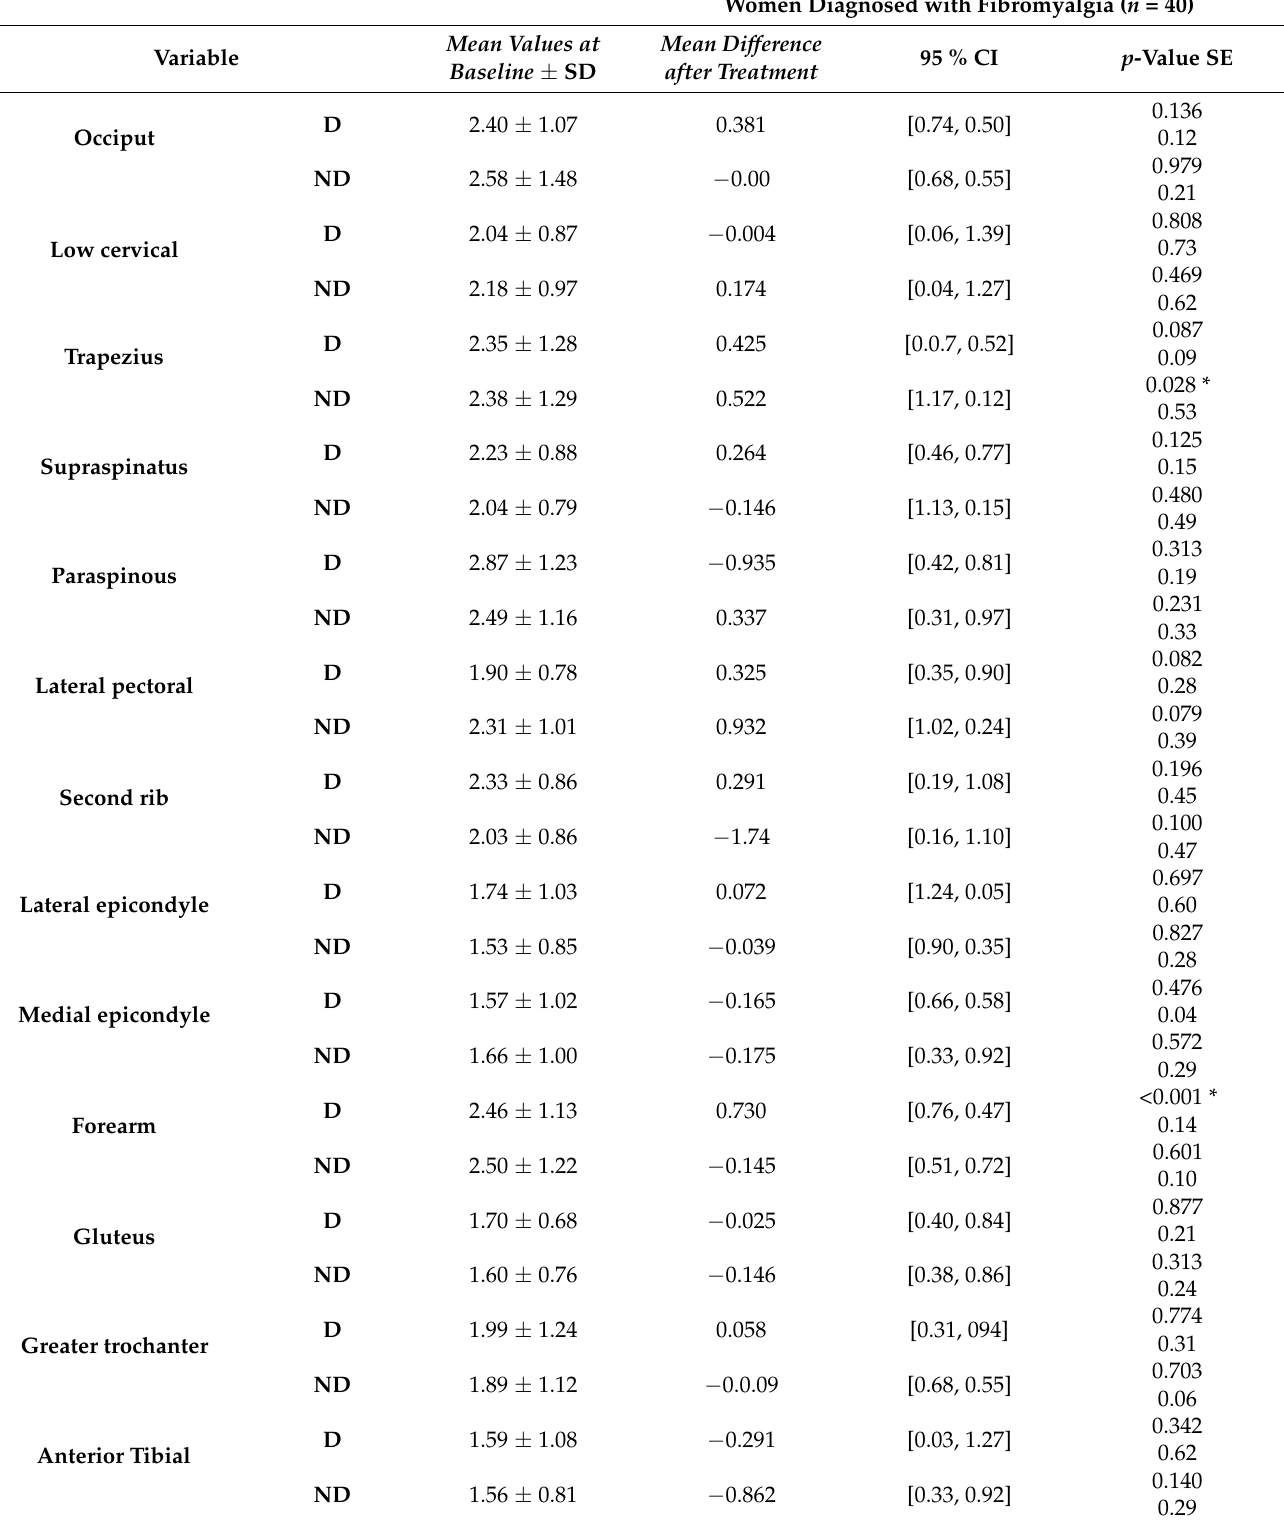
Table 4. Between groups differences in SEL in tender points after the intervention